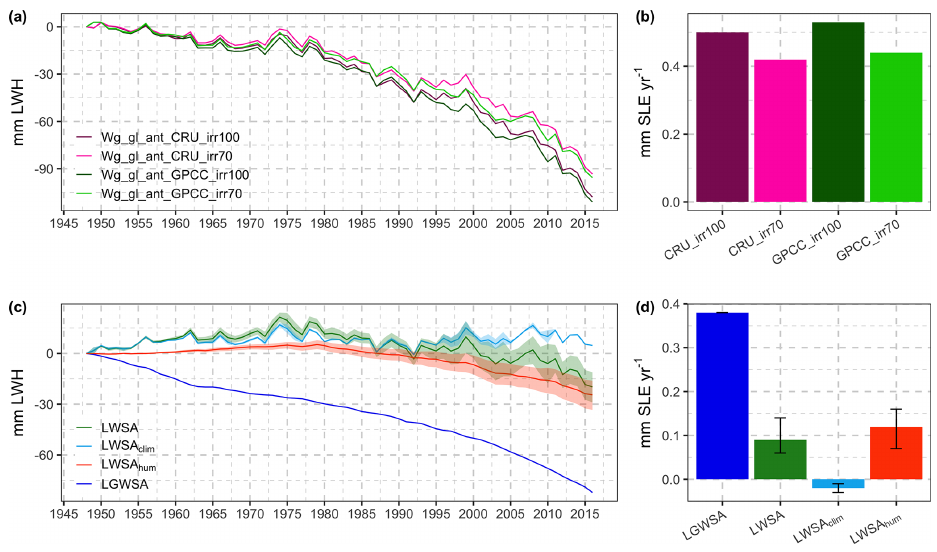
Figure 5. Global annual TWSA and individual contributions from 1958 to 2016. TWSA was computed with four variants of integrated WaterGAP in anthropogenic mode (Table 1) and disaggregated into land glacier water storage anomaly (LGWSA) and land water storage anomaly (LWSA). LWSA was further disaggregated into anomalies of climate-driven land water storage anomaly (LWSA clim ) and human- driven land water storage anomaly (LWSA hum ) . (a) Time series of TWSA and (b) corresponding linear trends of contribution of TWSAs to ocean mass change over 1948–2016. (c) Time series of LWSA, LWSA clim , LWSA hum and LGWSA (for each ensemble the curve represents the ensemble mean, and the shaded area around the curve represents the ensemble range) and (d) corresponding linear trends (ensemble ranges are represented as error bars). Anomalies are relative to the year 1948 and given in millimetres of land water height (mmLWH). Trends are given in millimetres of sea level equivalent per year (mmSLEyr − 1 ) ; positive trends translate to ocean mass gain, whereas negative trends translate to ocean mass loss.